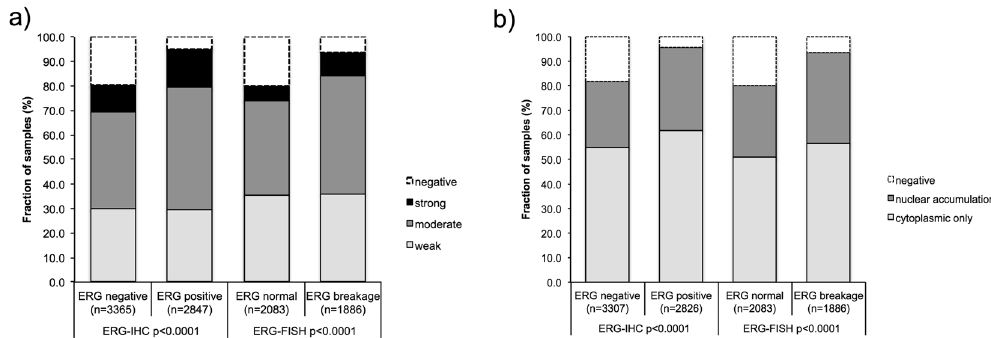
Figure 2. Association between positive YB-1 staining and TMPRSS2:ERG- fusion status as measured by immunohistochemistry (IHC) and fluorescent in situ hybridization (FISH) ( a ) cytoplasmic YB-1 staining, ( b ) nuclear YB-1